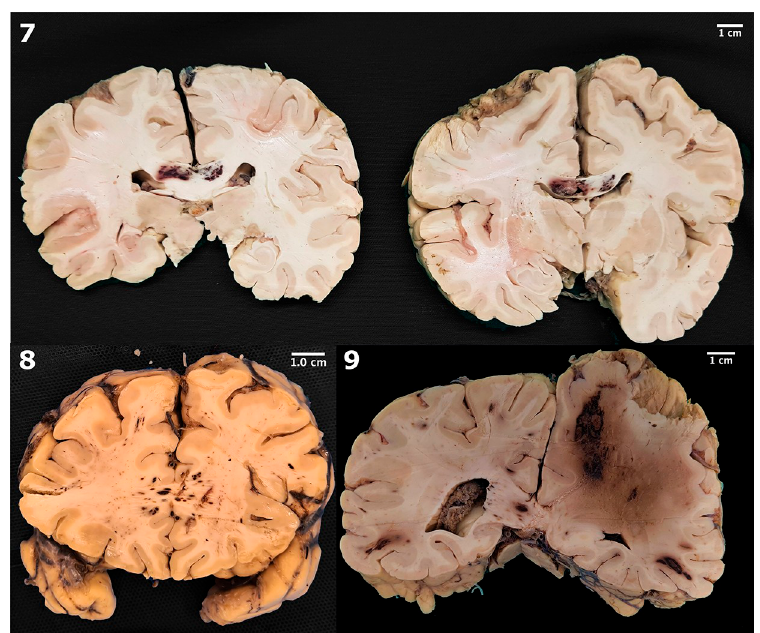
Fig 2. Gross pathology of macroscopic hemorrhages. 7. Hemorrhage in corpus callosum; 8. Hemorrhages in forceps major (occipitalis); 9. Extensive hemispheric hemorrhage, with intense deviation from the midline.